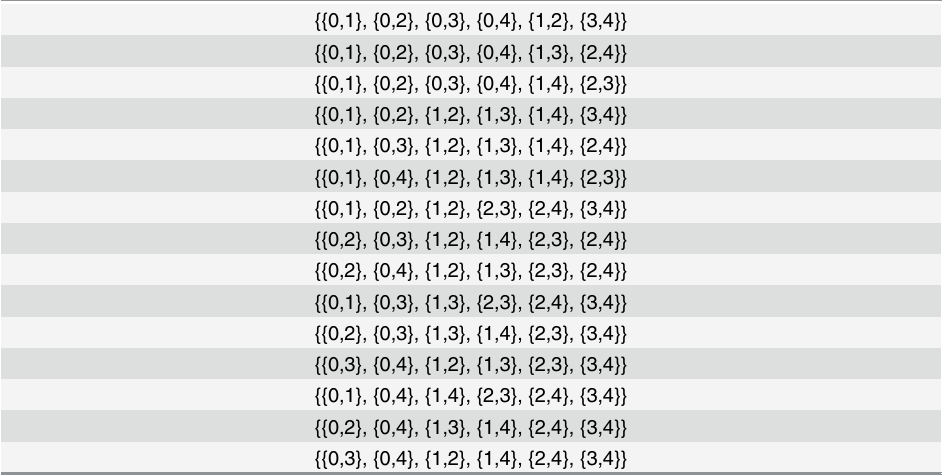
Table 2. All edge sets that are isomorphic to graphlet